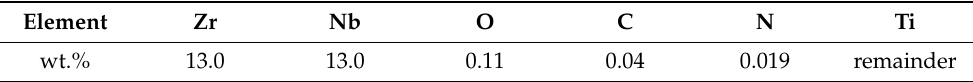
Table 1. The chemical composition of the Ti-13Zr-13Nb alloy, wt.%. (based on the manufacturer’s cer-